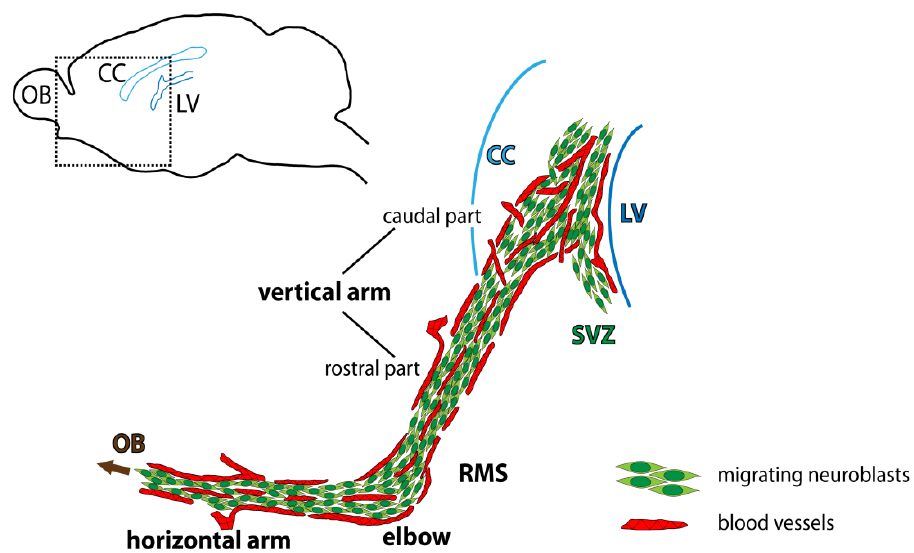
Figure 3. Vasculature-guided neuroblast migration in the RMS. Schematic drawing depicting neuroblasts migrating in chains along blood vessels. SVZ—subventricular zone, RMS—rostral migratory stream, OB—olfactory bulb, CC—corpus callosum, LV—lateral ventricle.